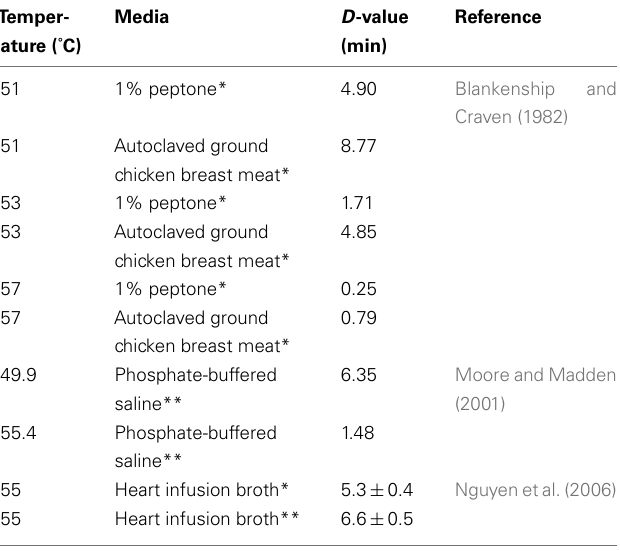
Table 1 | Reported D -values for Campylobacter jejuni and C. coli under different